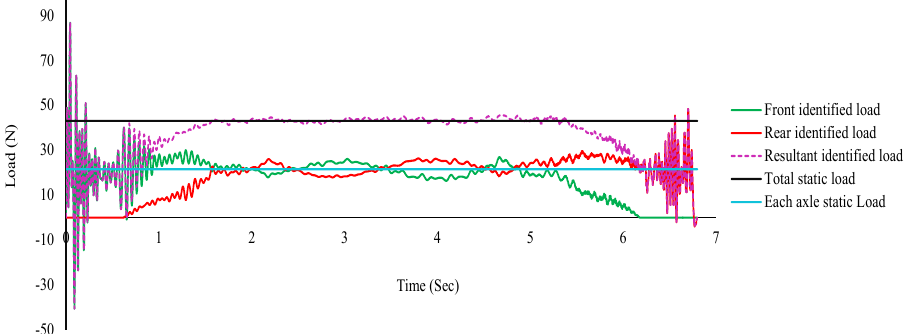
Figure 21. Identified front, rear, and resultant load in comparison with the static axle load and static weight of the car (sensor placement #2).